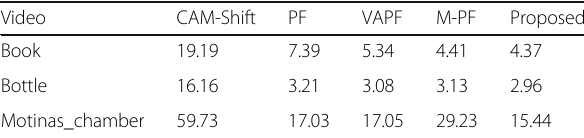
Table 6 Resulting of averaged angle error